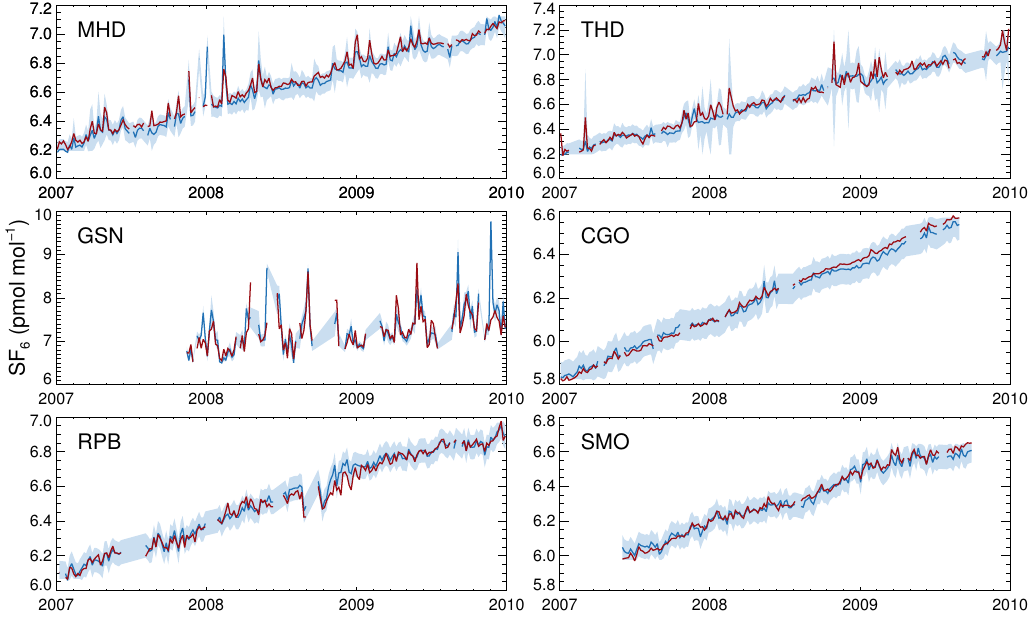
Fig. 8. Optimized 5-day average SF 6 mole fractions (red) and observations (blue) at six AGAGE sites used to derive global emissions. Shading indicates 1-sigma model–measurement uncertainty.